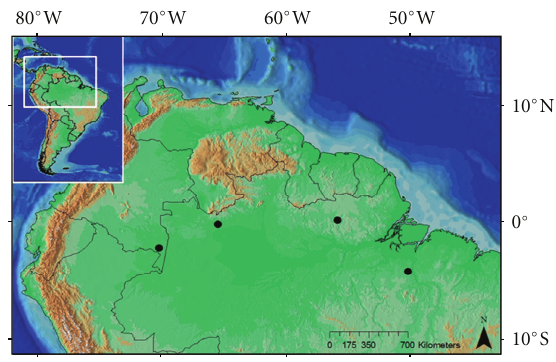
Figure 2: Distributional map of Ageniella ( Neotumagenia ) amazon-